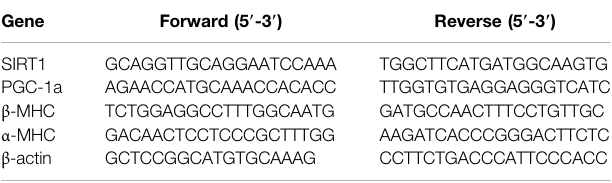
TABLE 1 | Primers used for